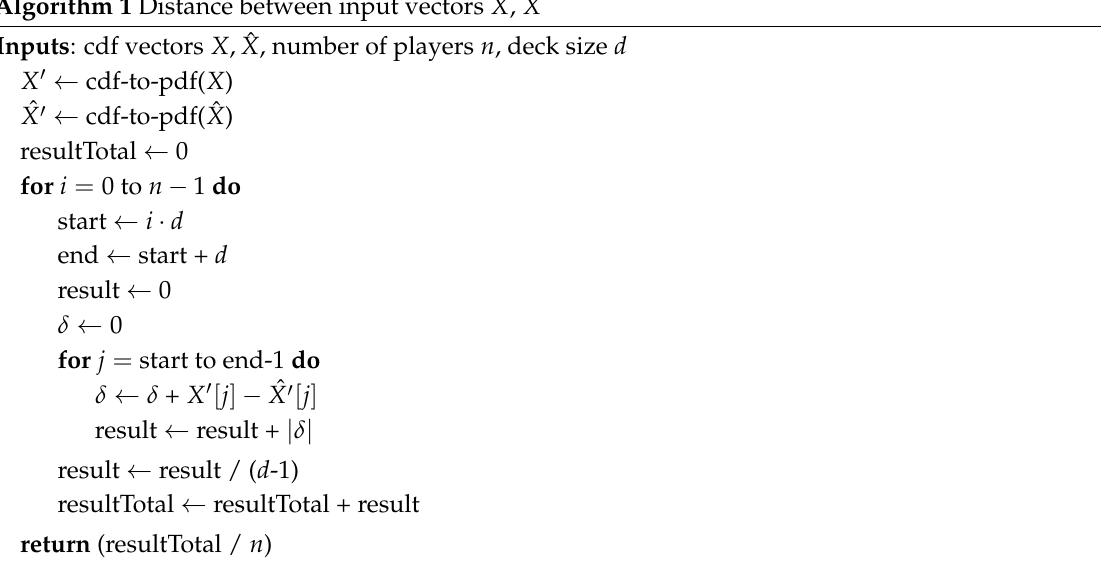
Algorithm 1 Distance between input vectors X , ˆ